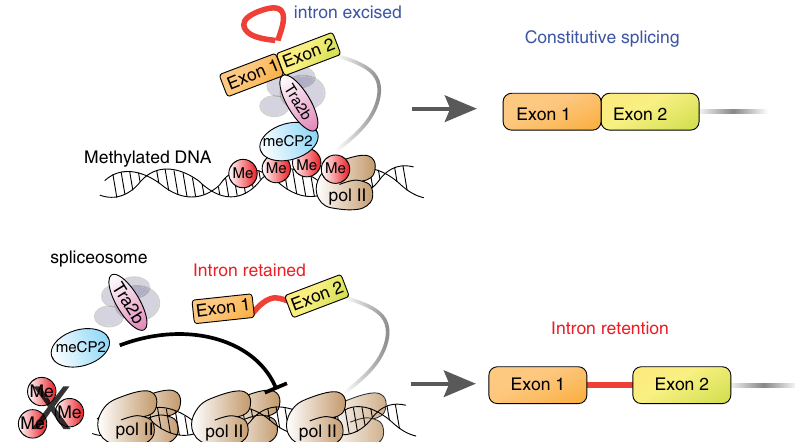
Figure 6 | Proposed model of IR regulation. IR occurs via less efficient splicing factor (e.g. Tra2b) recruitment consequent to reduced DNA-methylation- mediated MeCP2